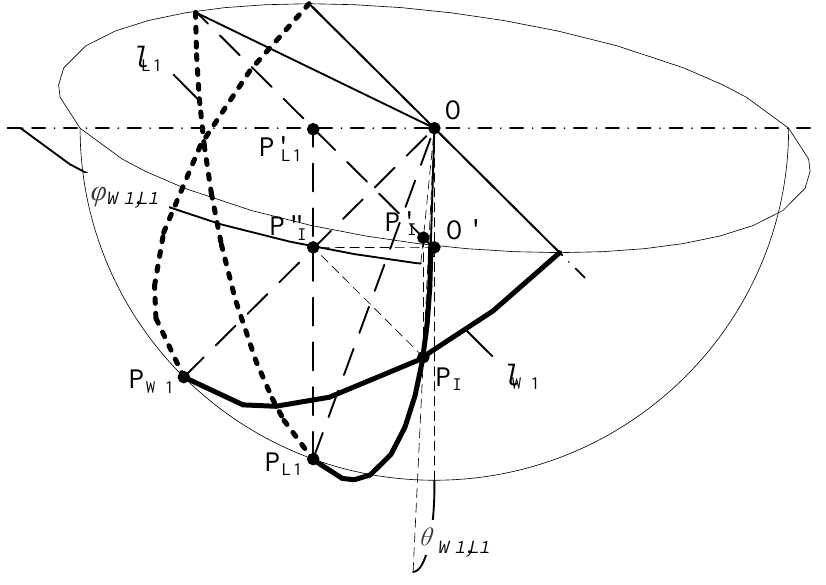
Figure A12. Ω L geometric sketch 2. Figure A12. Ω L geometric sketch